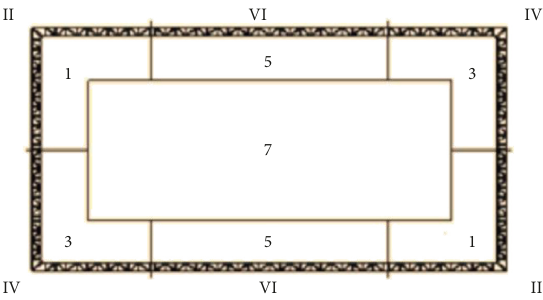
Figure 13: Shaft excavation and supporting